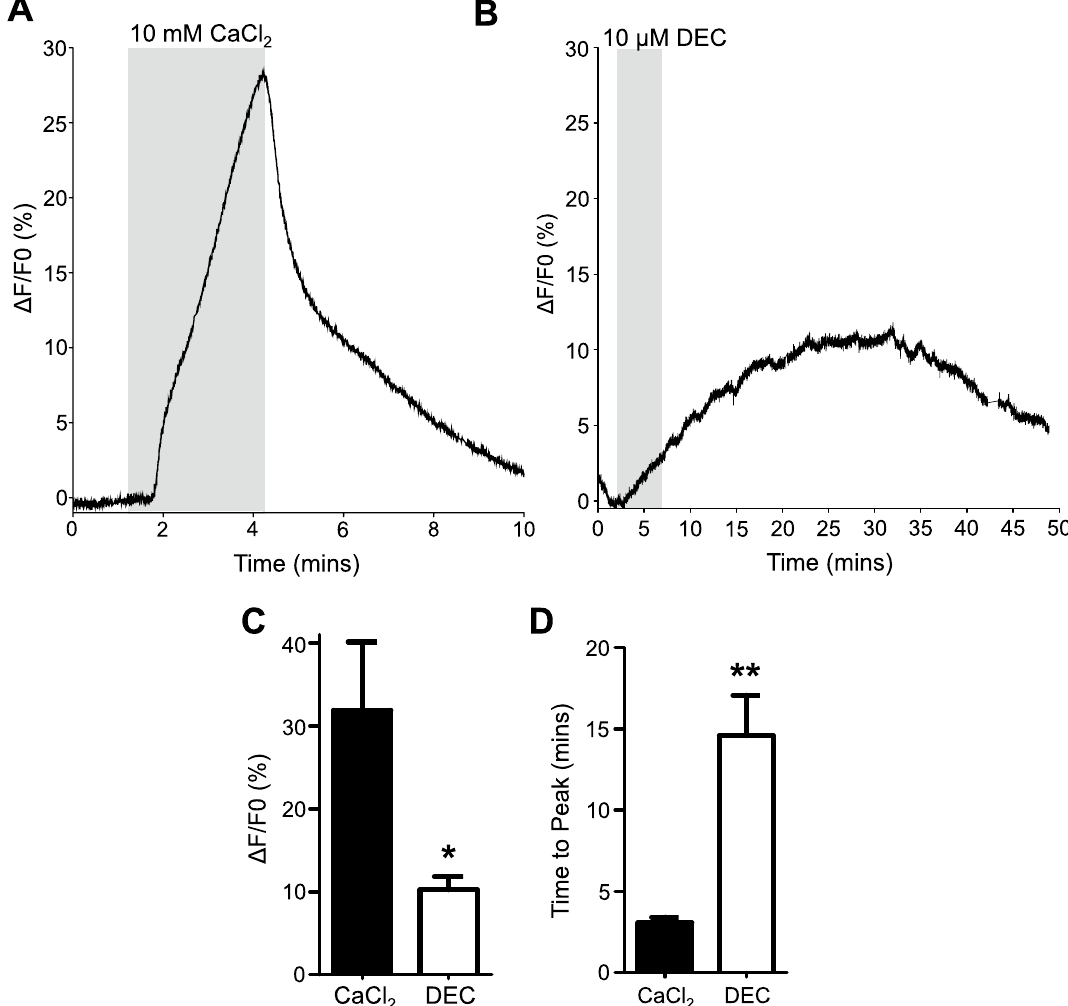
10 mM CaCl 2 . Grey box indicates 10 mM CaCl 2 application. ( B ) Representative Ca 2+ response to 10 µM DEC. Grey box represents DEC application. ( C ) Total amplitudes of Ca 2+ induced Fluo-3 fluorescence in response to 10 mM CaCl 2 and 10 µM DEC. *significantly different to CaCl 2 (CaCl 2 vs DEC P < 0.0255, t = 2.827 df = 7, paired t -test) n = 8 intestines from 7 female worms. ( D ) Quantification of time for Ca 2+ to reach maximum in response to 10 mM CaCl 2 and 10 µM DEC. **significantly different to CaCl 2 (CaCl 2 vs DEC P < 0.0014, t = 5.122, df = 7 paired t -test) n = 8 intestines from 7 female worms. All values represented as means ±